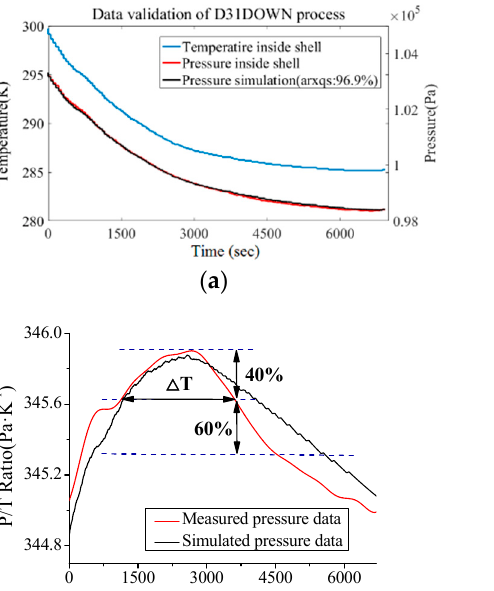
( f ) Figure 8. Data validation between real measurement group and predicted simulation group ( T c - P ).